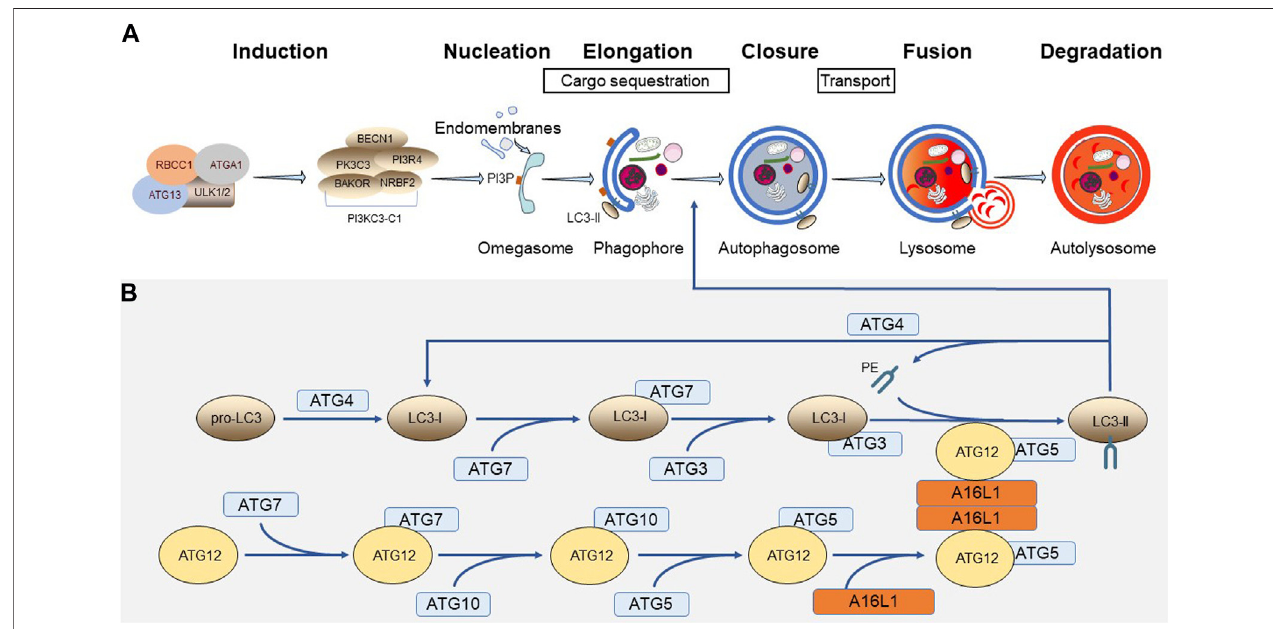
FIGURE 1 | Distinct steps and core components of autophagy. (A) Different stages of canonical autophagy. (B) Ubiquitin-like conjugation systems involved in phagophore biogenesis.